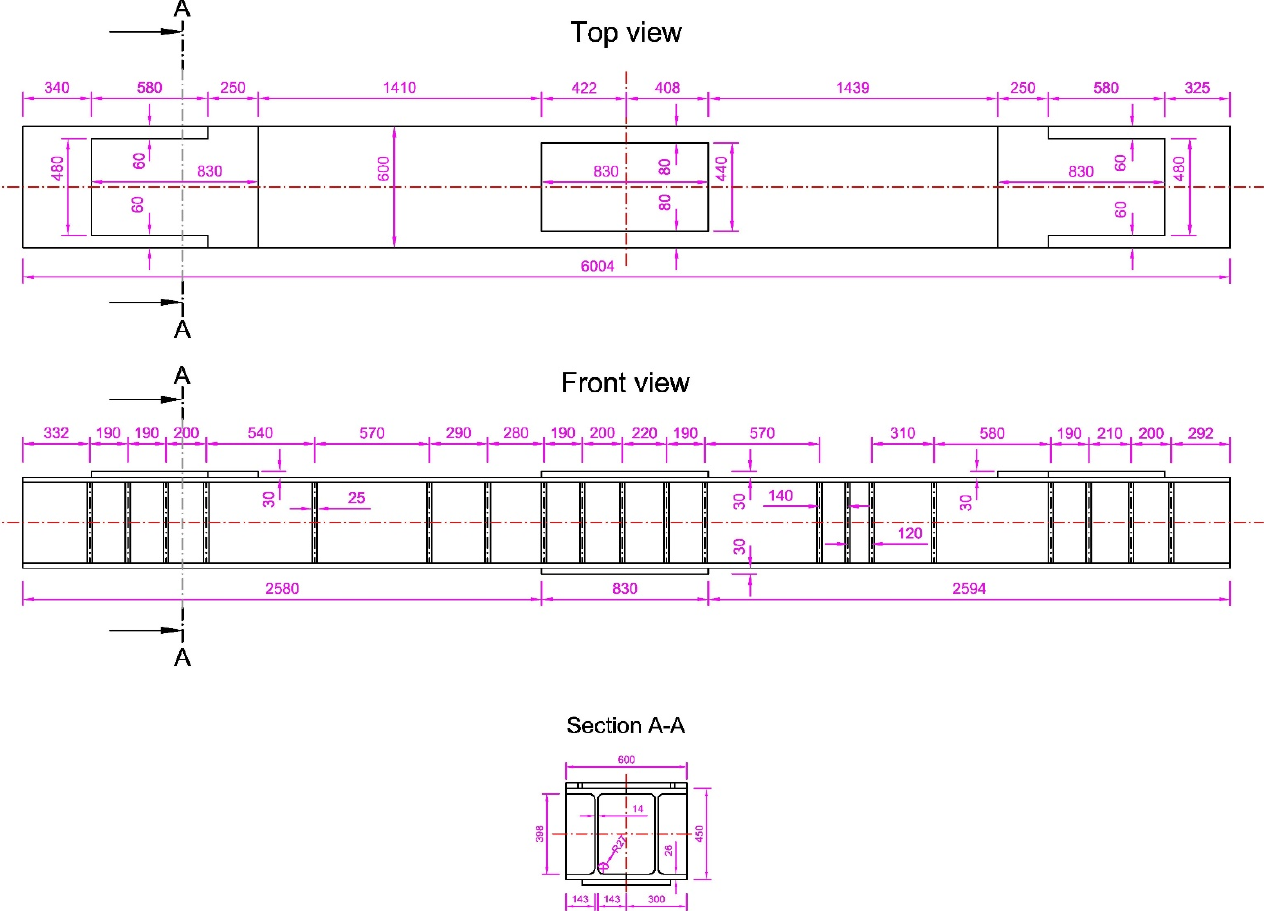
Figure 11. The dimensions of the reaction beam (top view, front view, and section A-A).